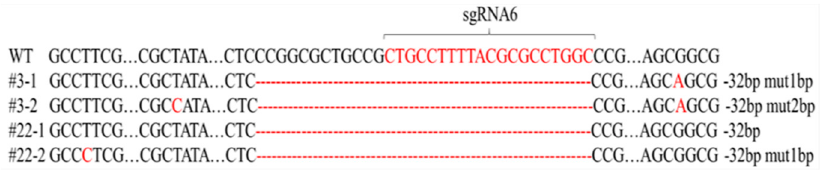
Figure 2. Real time qRT-PCR analysis of MyoD1 gene expression for the two selected cloned cell lines. ** p < 0.01. 3.2. Transcriptome Sequencing We utilized the clone gRNA6 cells for genomic analysis and procured >40 million clean reads for both wild type and MyoD1 knockout MDBK cells, and high-quality read percentages were accessed by a comparison to the reference genome. The total number of sequences was >36 million and the alignment rate was 89% (Table 4). In addition, tran- scriptome analysis indicated >4000 new transcripts, 4600 generated by variable splicing and >36,000 SNPs in wild type MDBK cells and 6300 new transcripts, 4500 variable splic- ing, and 38,000 SNPs in MyoD1 knockout MDBK cells (Table 5). By using clustering anal- ysis of all samples (Figure 3), we can infer that MyoD1 knockout was effectual, and some genes were used to perform difference and significance analysis (Pheatmap).